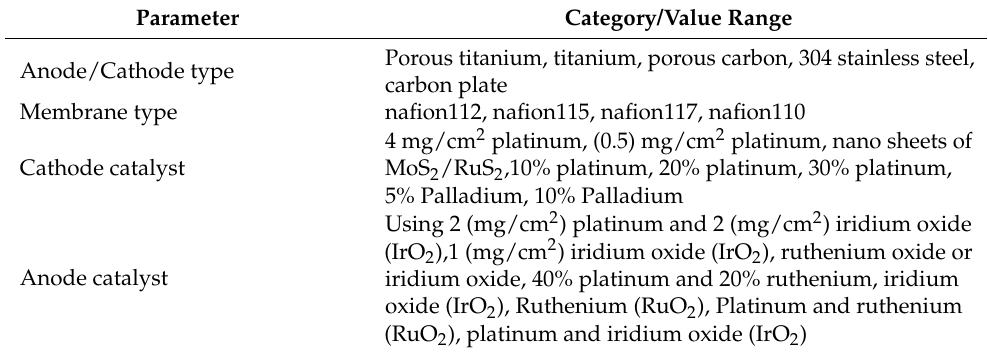
Table 1. Categories and Values range of the